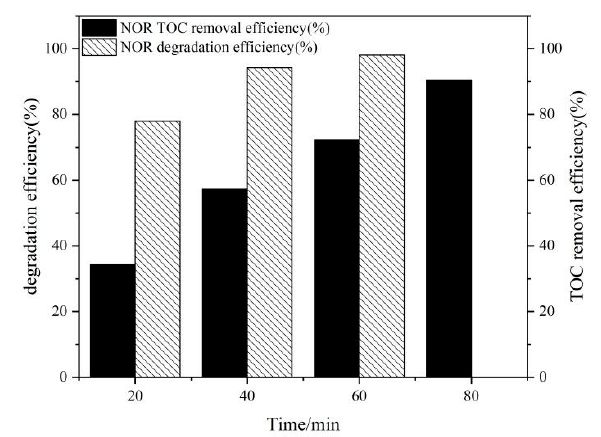
Figure 8. The degradation efficiency and the total organic carbon (TOC) removal efficiency of NOR with 10 mg/L initial concentration in PFC/PS system. Experimental conditions: [PS] = 3 mM, pH = 3, and electrolyte: 0.1 M Na 2 SO 4 .